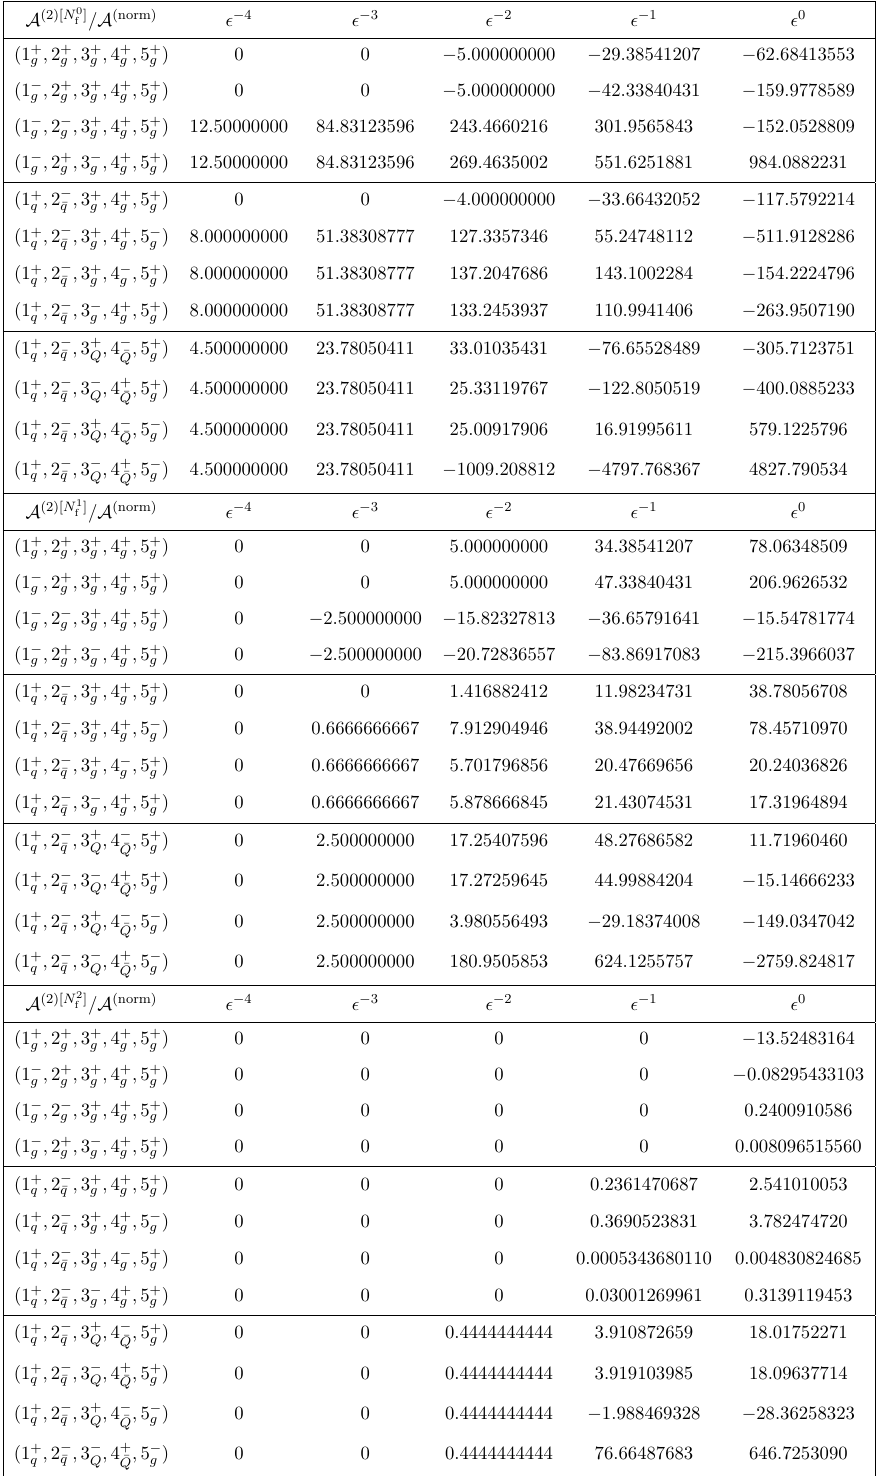
Table 2 . The bare two-loop (cid:12)ve-parton helicity amplitudes evaluated at the phase space point in eq. (4.2). We set the normalization factor A (norm) to A (1)[ N 0 f ] ( (cid:15) = 0) for the amplitudes with vanishing trees, and to A (0) otherwise.